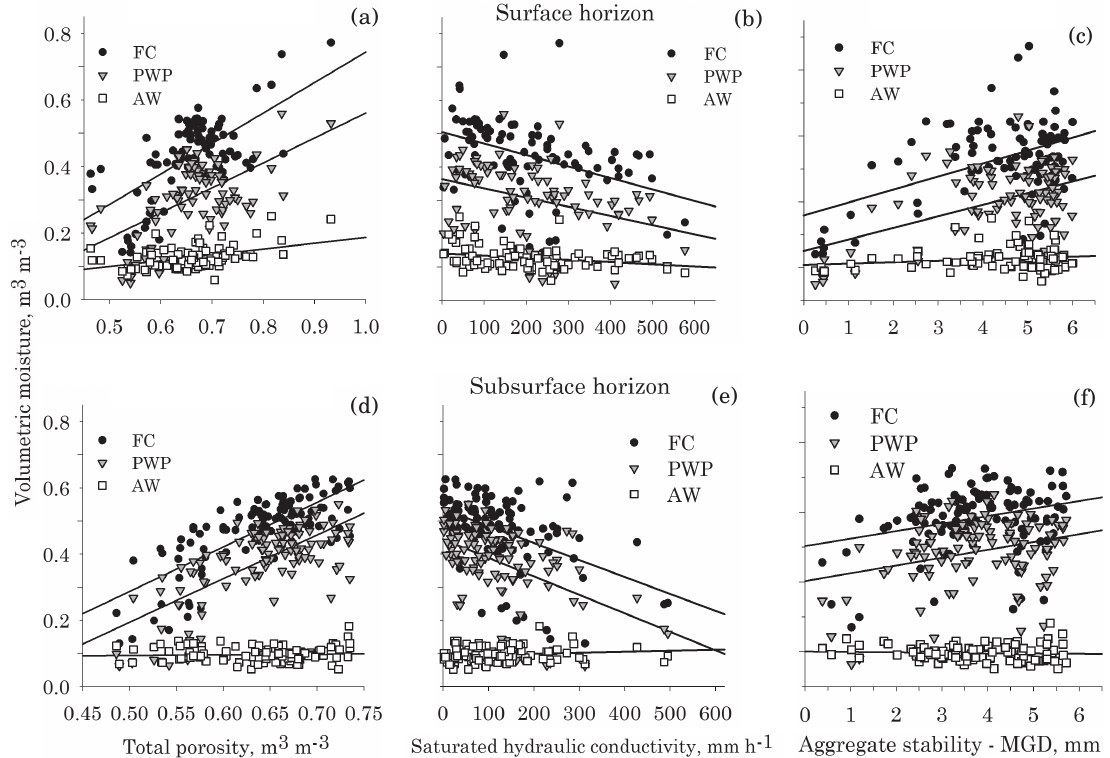
Figure 4. Scatter plots between the field capacity (FC), permanent wilting point (PWP) and available water content (AW) versus total porosity, saturated hydraulic conductivity and aggregate stability, expressed by the mean geometric diameter (MGD) in surface (a, b, c) and subsurface (d, e, f) horizons in soils of the State of Santa